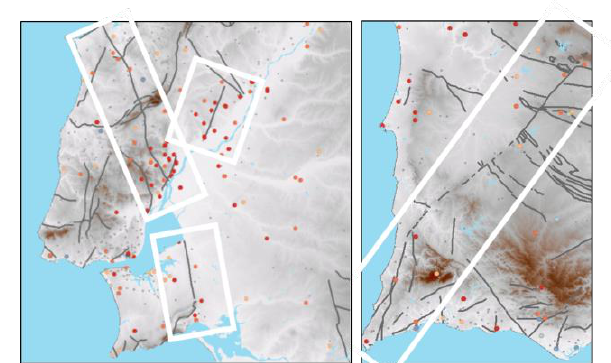
Figure 8. Hot spot analysis of Getis–Ord Gi* with a representation of the main geological faults. Left: Lisbon and Tagus valley regions. Right: SW Portugal. White boxes highlight locations where spatial correlation between hot spots and geological lineaments orientations is